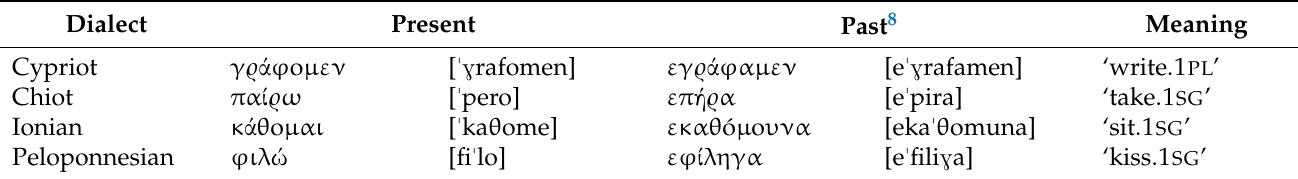
Table 4. Examples of augment retention in Modern Greek dialects.